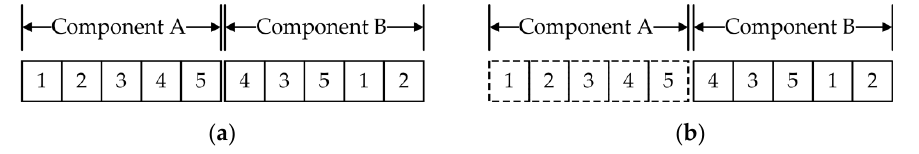
Figure 6. Encoding: ( a ) Kannan Encoding; ( b ) Rezaei Aderiani Encoding.